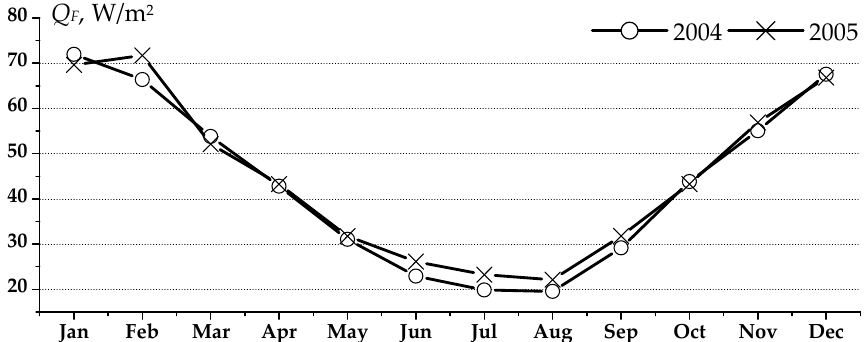
Figure 5. Annual dynamics of the anthropogenic heat flux Q F emitted within the city in Tomsk.